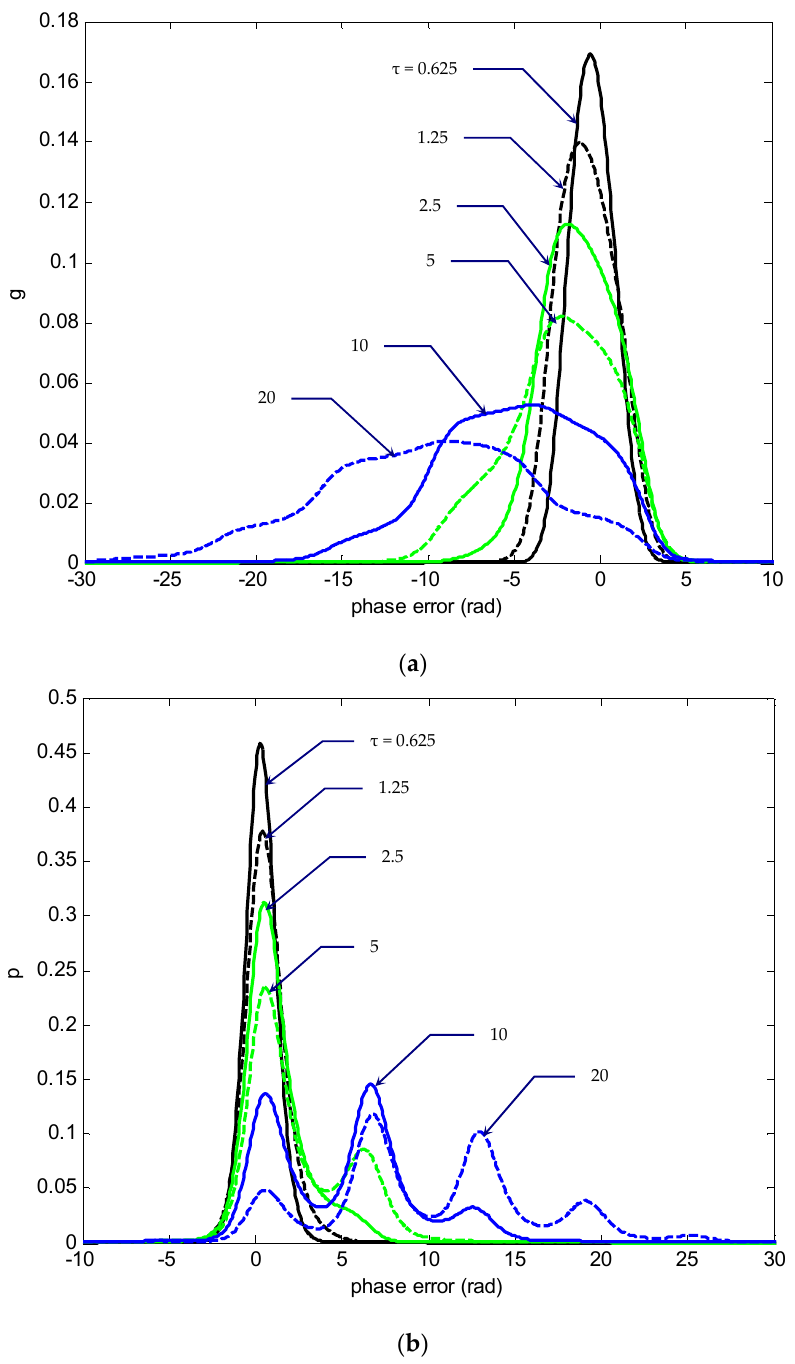
Figure 5. The time-evolution of the nonmodulo-2 π ( a ) density function g ( φ , τ ) and ( b ) PDF p ( φ , τ ) , of the phase error for SNR α = 1 ( γ = sin ( π /4 )